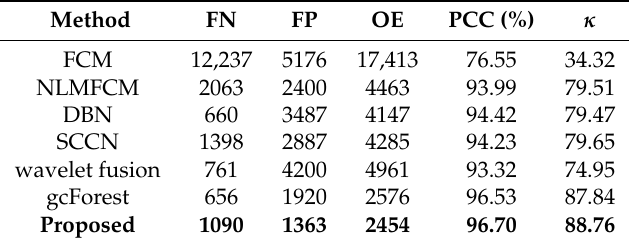
Table 1. Value of the evaluation criteria of the Farmland D data